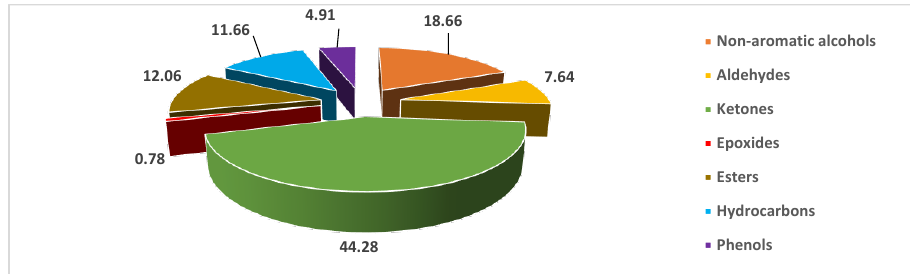
Figure 2. Distribution of chemical classes identified in C. sativus EO (%). Table 2. Chemical profile (GC/MS) of the essential oil of C. sativus. Table 3. Results of phytochemical tests.